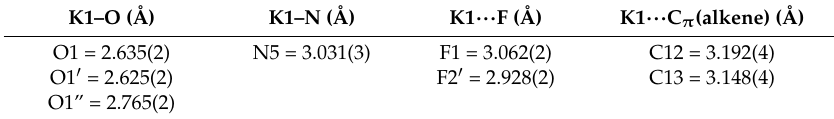
Table 3. Key metric parameters in the potassium–alkene complex [{RO 3 }K] 4 ([ 3 ] 4 ).